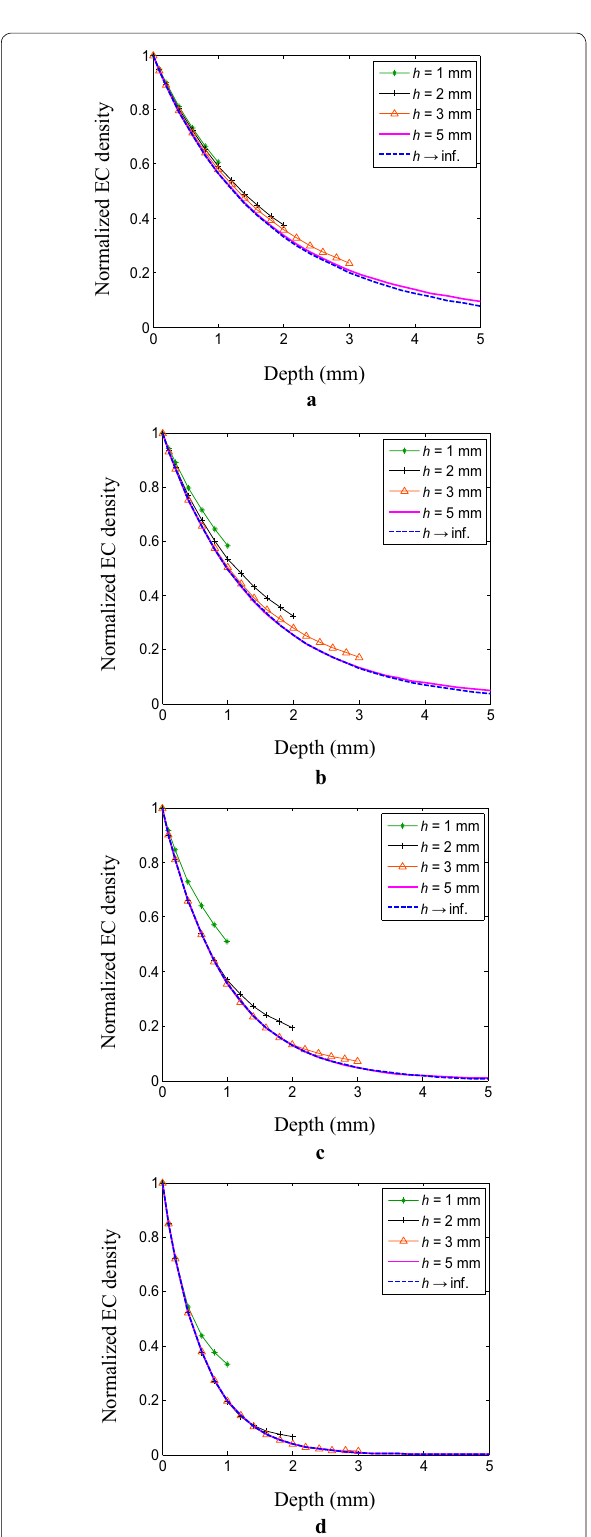
Figure 6 Normalized EC densities as functions of depth for various plate thicknesses: a 1 kHz; b 3 kHz; c 10 kHz; d 30 kHz